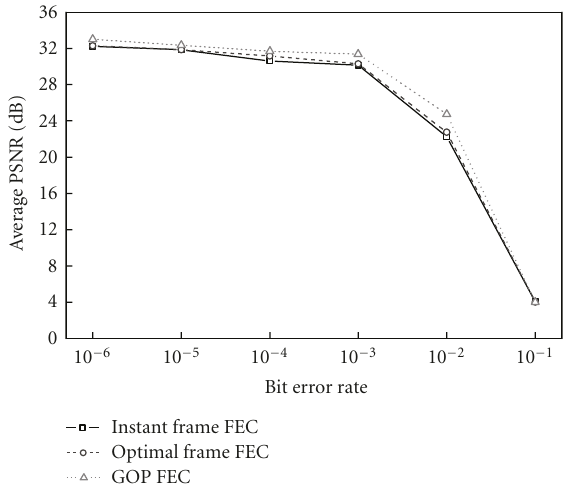
Figure 12: PSNR comparison with varied bit error rate.